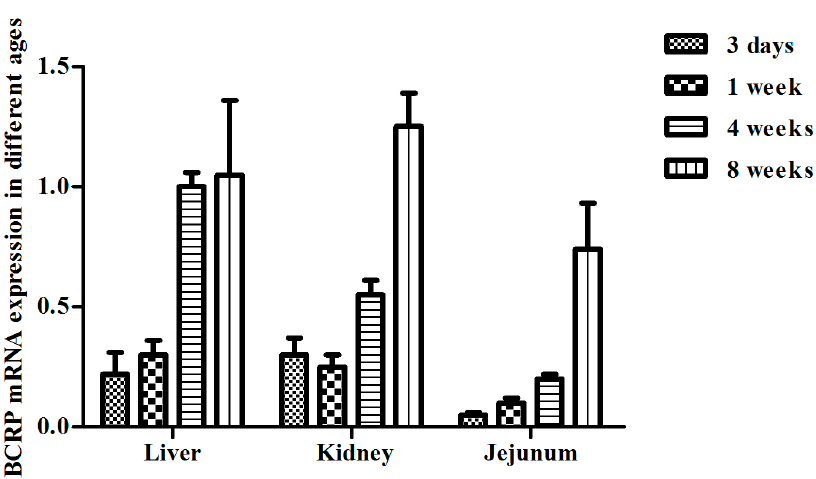
Figure 3. Comparison of the BCRP mRNA levels in different ages. Data are represented as mean ± SD ( n = 5).